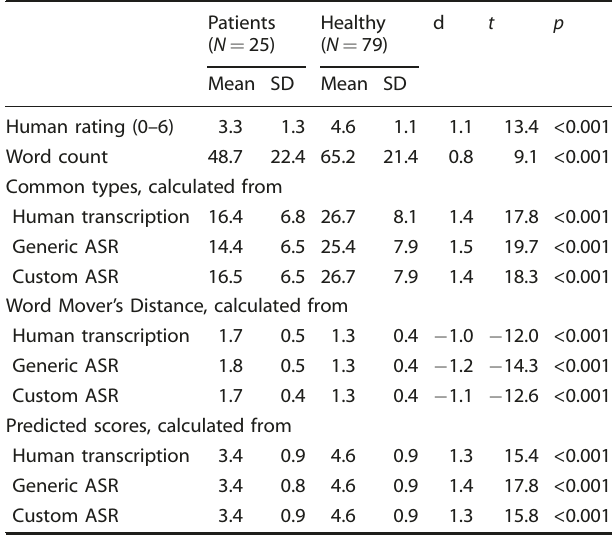
Table 2. Description of calculated measures, by group and transcription method.